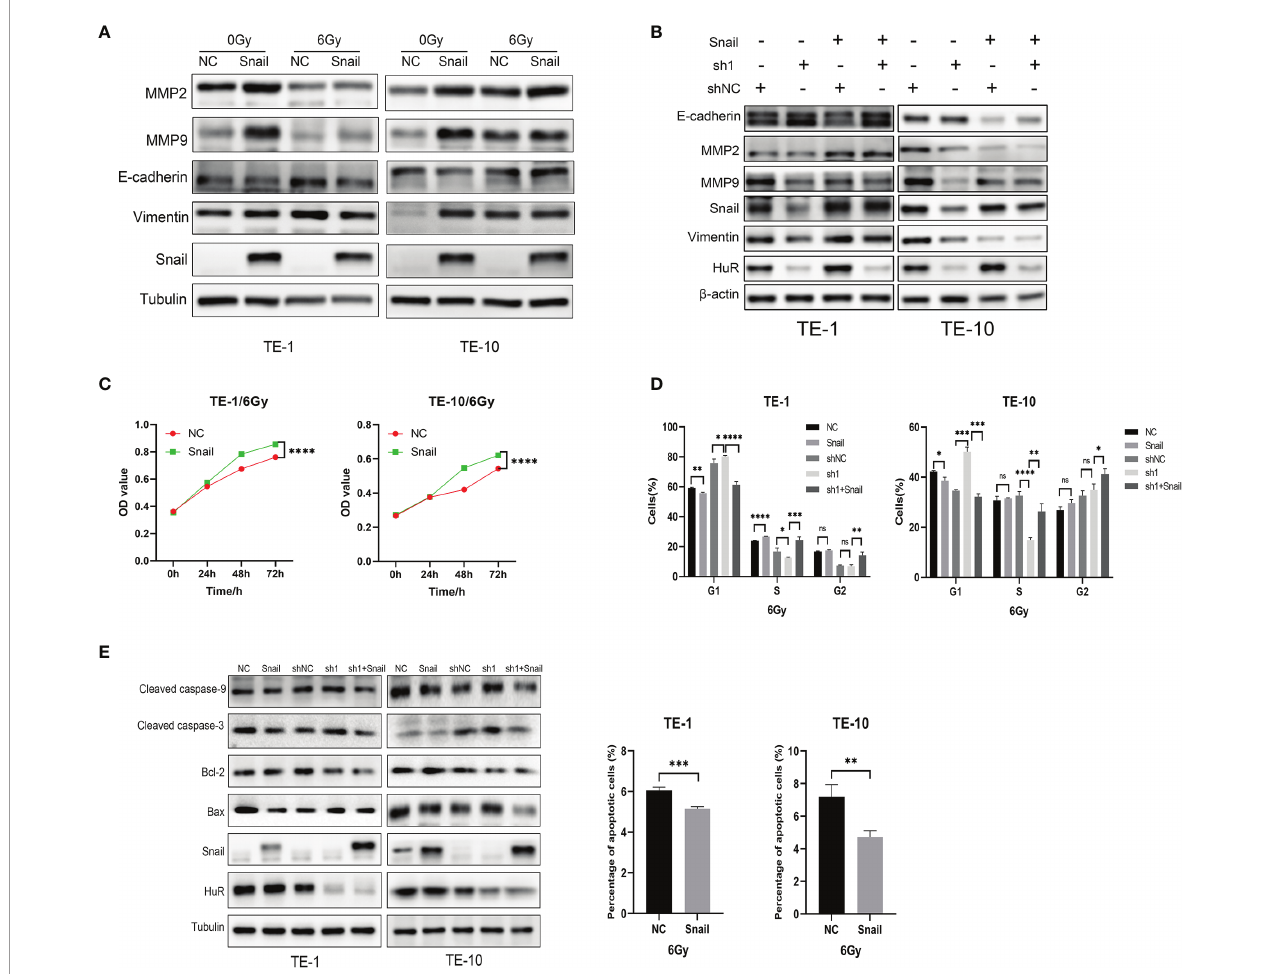
FIGURE 6 | Snail attenuated the effects of X-rays on esophageal cancer cells. (A) Western blot was used to evaluate the expression of the expression of EMT-related proteins E-cadherin, MMP2, MMP9 and Vimentin in esophageal cancer cells after Snail was upregulated. (B) Western blot was performed to state that Snail can reverse the inhibitory effect of HuR on EMT-related proteins. (C) CCK8 was used to detect the proliferation of esophageal cancer cells combined with X-ray after Snail upregulation. (D) Flow cytometry detection of the effect of Snail on the cell cycle of esophageal cancer cells. The bar graph shows the proportion of cells. (E) Expression of apoptosis-related proteins Bax, Caspase-3, Caspase-9, and Bcl-2 were determined by Western blot. And Flow cytometry was used to detect the cell apoptosis of esophageal cancer cells after Snail upregulated. The bar graph shows the proportion of apoptotic cells. ns > 0.05, *p < 0.05, **p < 0.01, ***p < 0.001 and ****p <